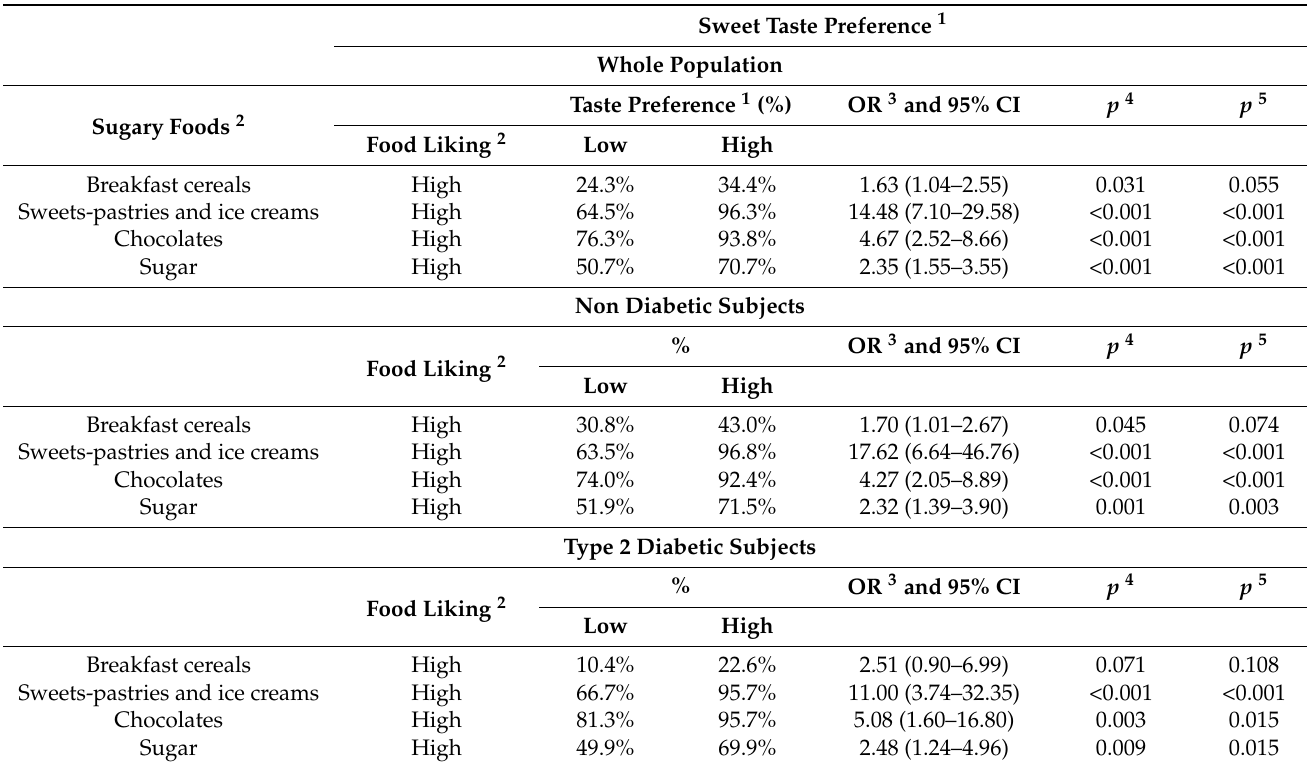
Table 5. Association between sweet taste preference (low/high) and liking for sugary foods (low/high) in the whole population and by type 2 diabetes